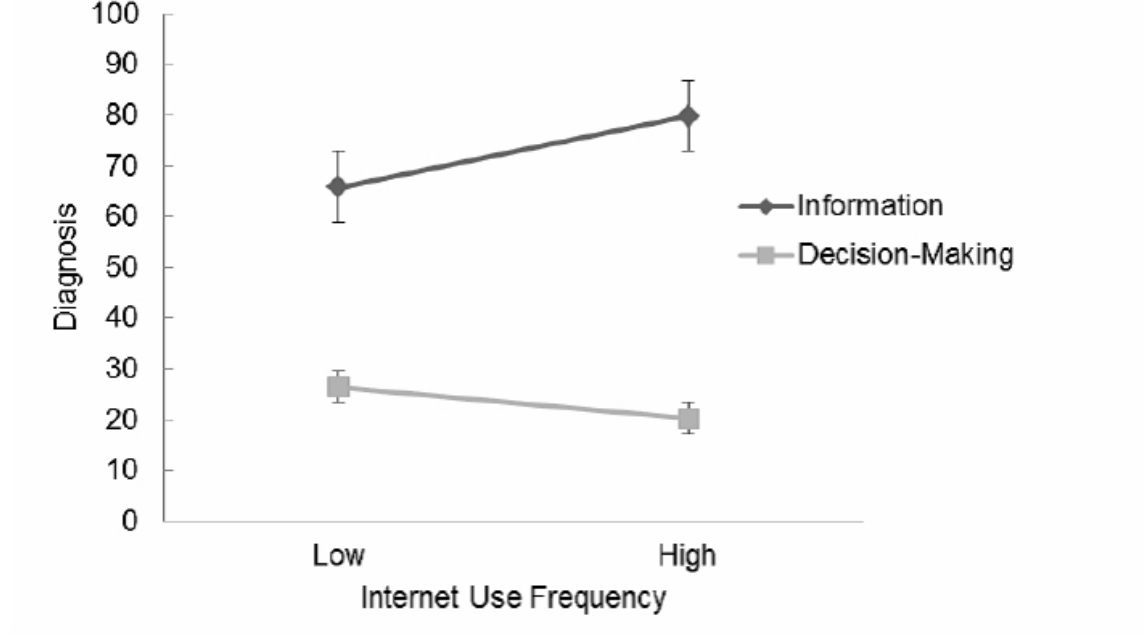
Figure 2. Interaction between Internet use frequency and rating dimension (Information vs Decision Making) for the Psychosocial